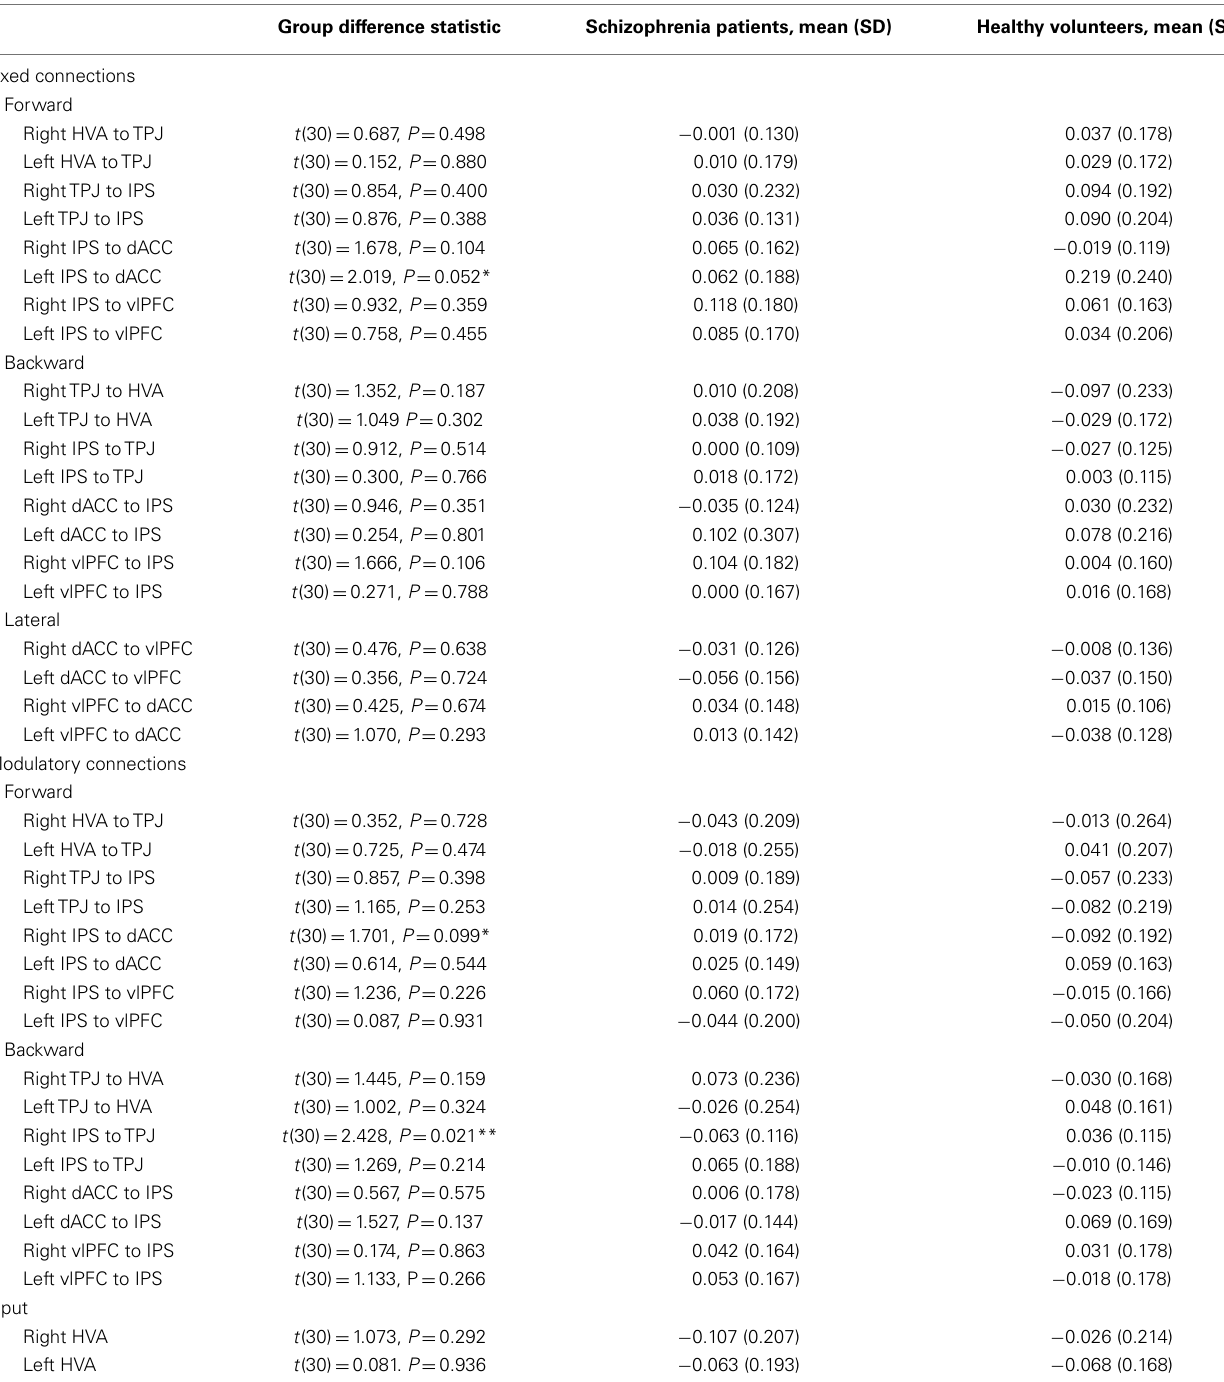
Table 4 | Connectivity estimates from Bayesian model